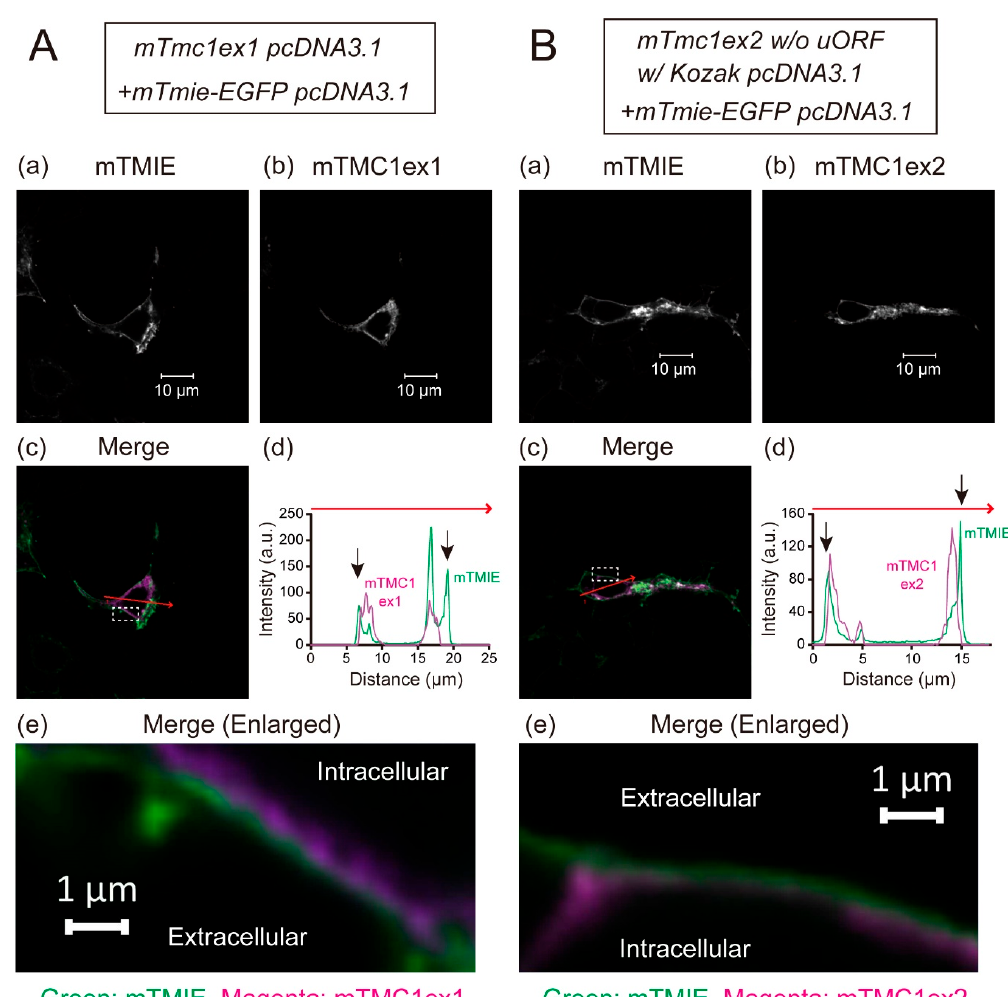
Figure 4. Representative images showing distributions of heterologously expressed mTMC1ex1 ( A ) and mTMC1ex2 ( B ) in HEK293T cells: ( a ) the signals of EGFP-tagged mouse transmembrane inner ear (mTMIE), which was co-expressed, and ( b ) the signals of mTMC1ex1 and mTMC1ex2, which were expressed using the WT mTmc1ex1 and the mutant mTmc1ex2 ( w/o uORF and w/Kozak sequence) in the pcDNA3.1 vector, respectively. ( c ) In the merged images, the signals of mTMIE are shown in green and the signals of mTMC1 are shown in magenta. ( d ) Signal intensities were measured along the randomly chosen red arrows on the merged images. The black arrows indicate the positions of mTMIE at the periphery of the cells. The signals of mTMIE were observed outside of those of mTMC1ex1 and mTMC1ex2. ( e ) Enlarged merged images of the area squared with a white dotted line in ( c ): The